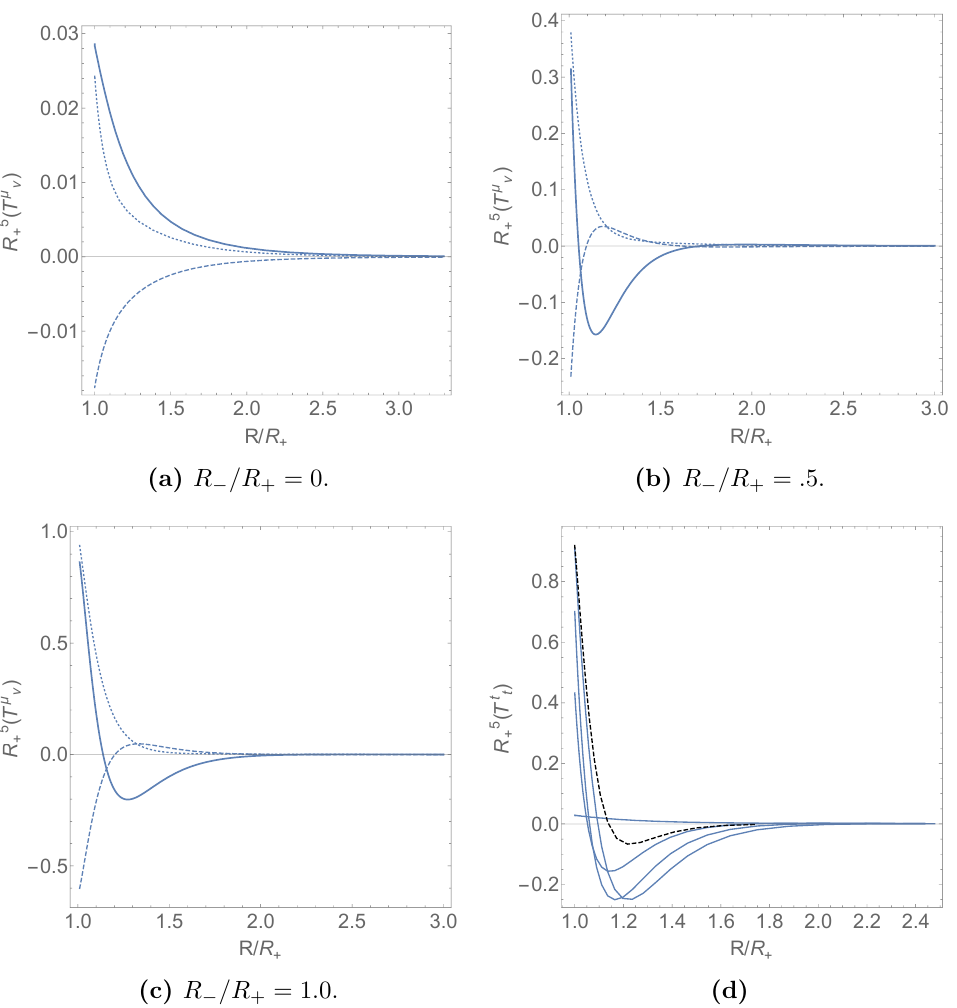
Figure 5. (a){(c) are plots of the (cid:12)ve dimensional 16 (cid:25)G 5 values of R (cid:0) =R + . In the plots, the thick line is the energy density T t the dashed line is T (cid:10) . In (d), we plot the energy densities for R (cid:0) =R + =0, .5, .7, .9, and 1.0 (black, (cid:10) dotted